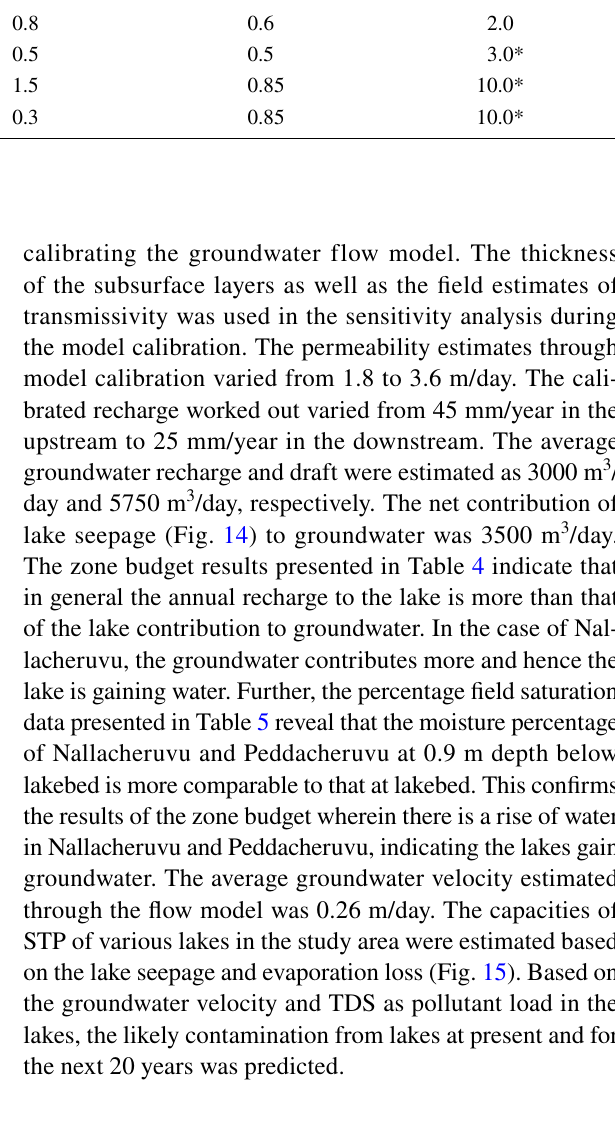
Table 5 Computed lake water seepage from groundwater flow model and proposed capacity of STPs in NE Musi